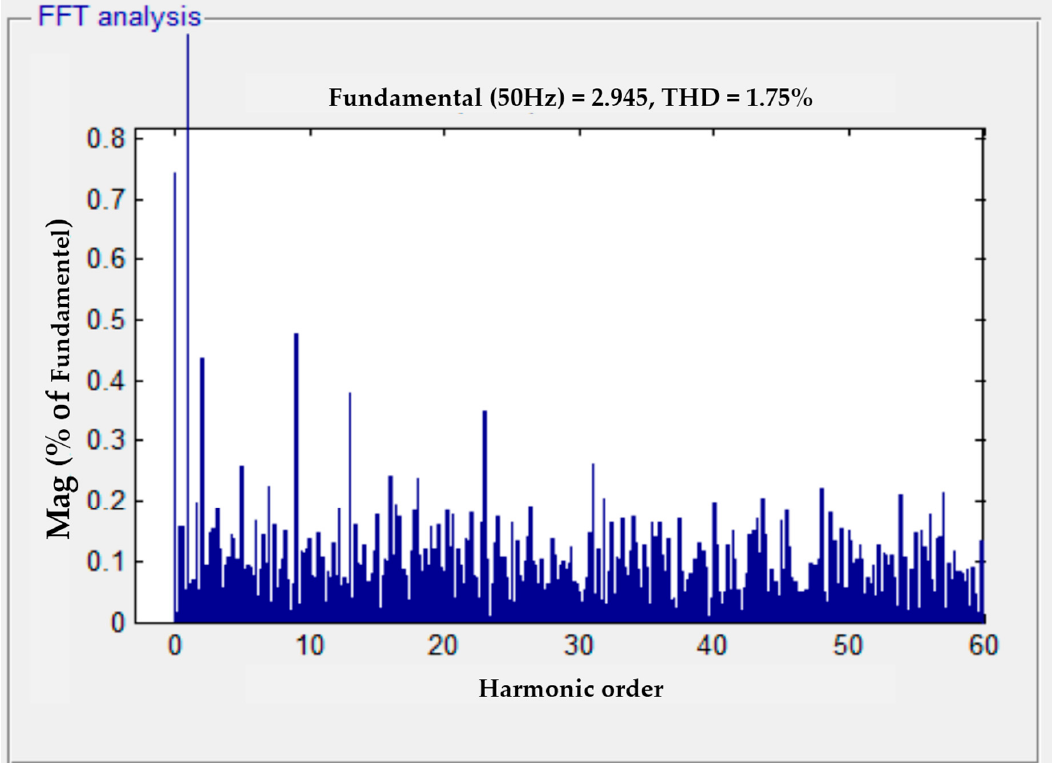
Figure 18. Measurements THD result of the input current of Phase A.